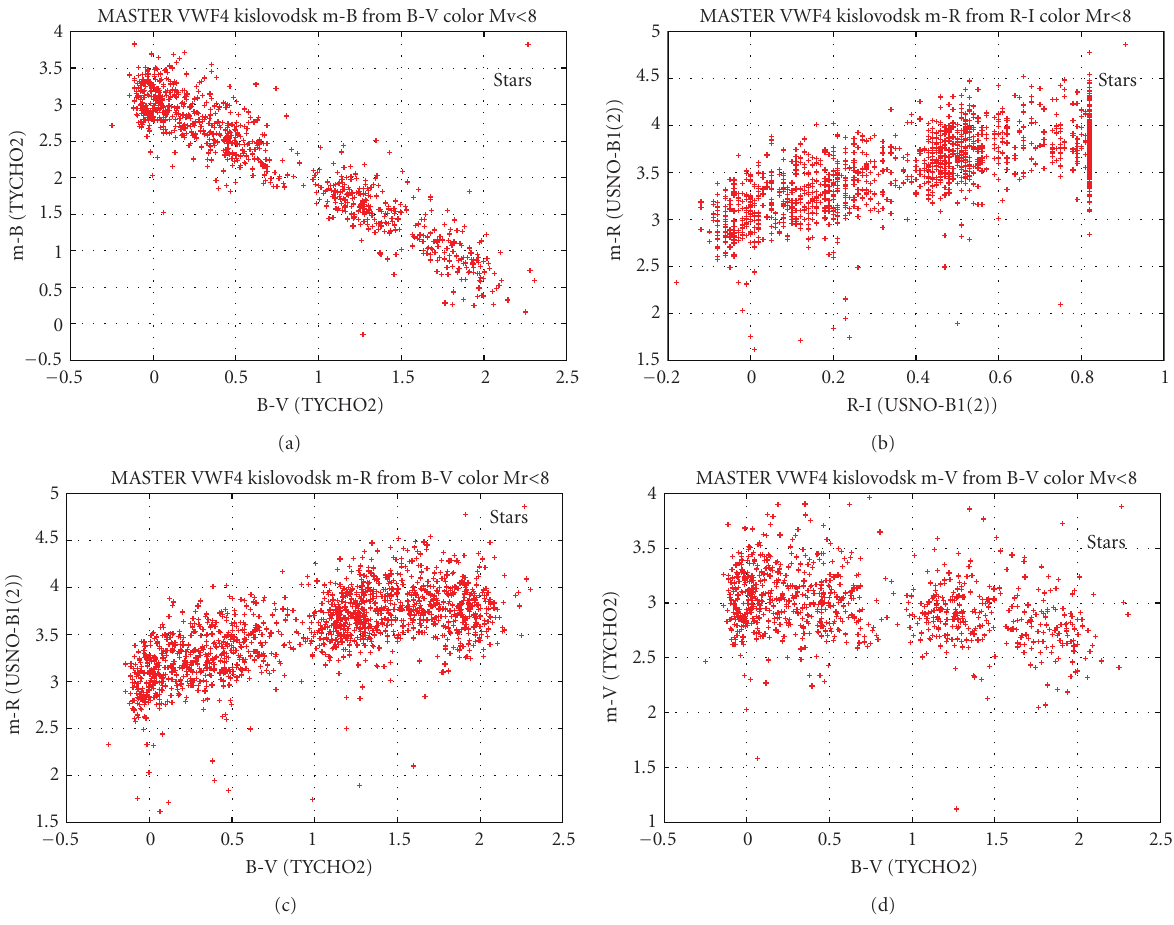
Figure 6: Color-color diagrams are used to calibrate instrumental magnitudes. On these plots m = 2 . 5lg( F inst ) and the zero point is of no importance and cannot be determined at the this stage. Note that the width of the sequences is real and due to the fact that stars have di ff erent spectral types, and not due to measurement errors. R-I = 0.82 clustered connected with non very